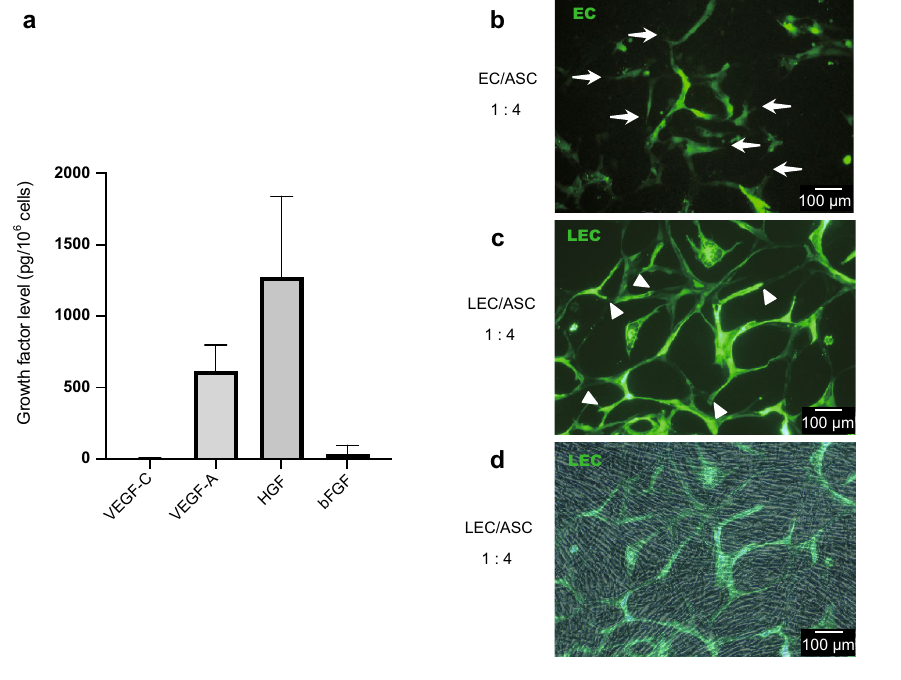
Figure 1. Secretion of growth factors by adipose-derived stem cells (ASCs) and the formation of networks by co-culture with endothelial cells (ECs) or lymphatic endothelial cells (LECs). ( a ) The levels of vascular endothelial growth factor-C (VEGF-C), VEGF-A, hepatocyte growth factor (HGF) and basic fibroblast growth factor (bFGF) in the medium bathing cultured ASCs were measured using enzyme-linked immunosorbent assays. HGF and VEGF-A were both secreted by ASCs, whereas the levels of secreted VEGF-C and b-FGF were much lower. ( b ) Green fluorescent protein (GFP)-expressing ECs and ASCs co-cultured at a ratio of 1:4. Networks of vascular ECs were observed, and the edges of the vascular EC network were sharp (arrows). ( c ) GFP-LECs and ASCs co-cultured at a ratio of 1:4. The LECs formed networks, but in contrast to vascular ECs, rounded/bulging structures were observed at the edges of the LEC network (arrowheads). ( d ) Merge image of ( c ) and phase-contrast image. ASCs shows random pattern with no specific character which do not form own network or support LEC network